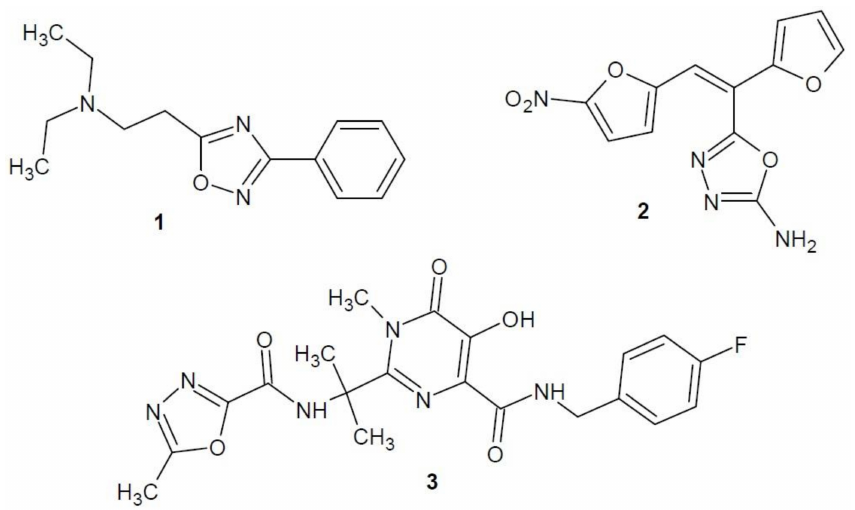
Figure 2. Drugs with oxadiazole